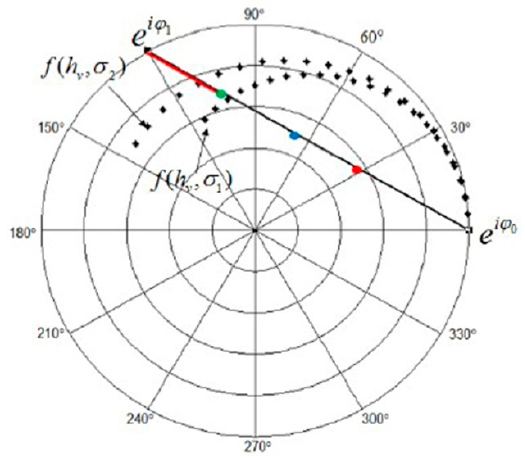
Figure 4. The three-stage algorithm procedure representation. Blue, red, and green circles depict the coherence values in the Pauli basis. The black line is the coherence line and the ground coherence candidates have been shown by e i ϕ 0 and e i ϕ 1 . The ambiguous line segment has been shown by red line. The black stars are the fixed extinction coherence loci [7].